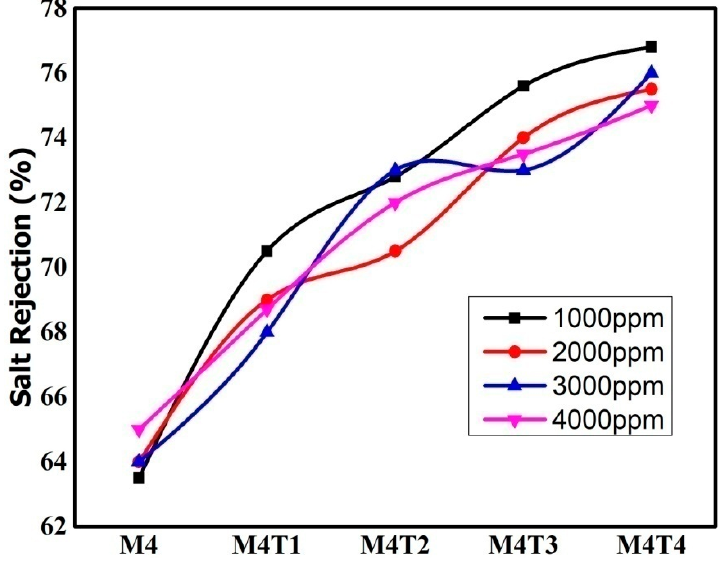
Figure 9. Salt rejection of the NaCl solution at various concentrations.